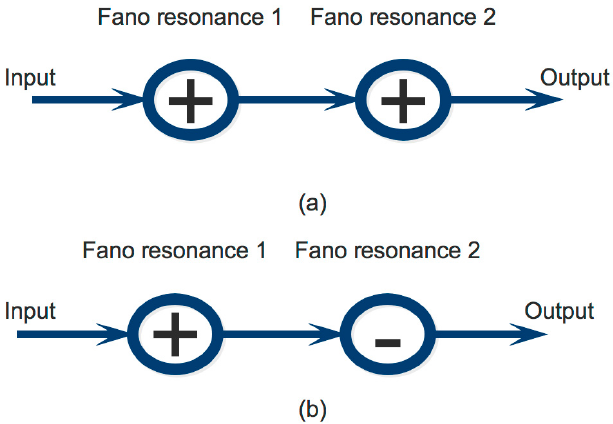
Figure 4. Schemes of Coupled Fano resonances ( a ) bar connect and ( b ) cross connect.